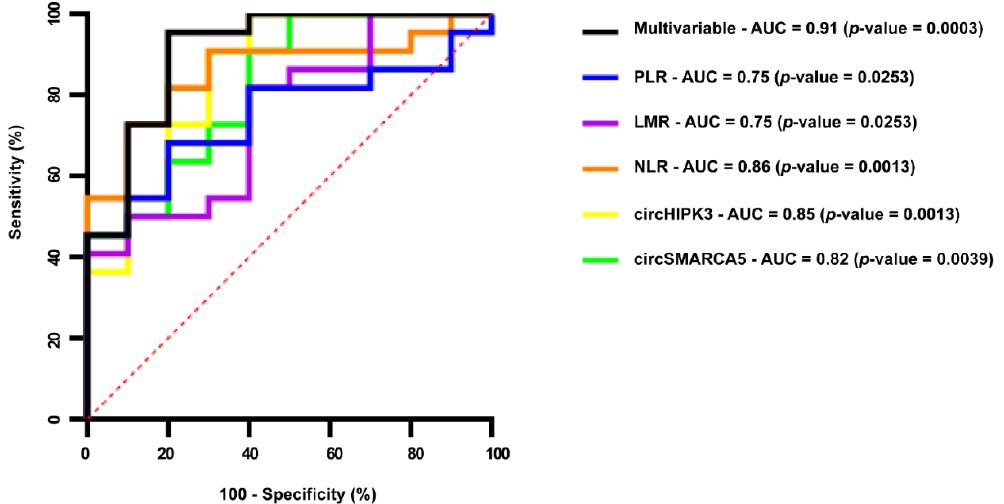
Figure 4. Univariable and multivariable receiver operating characteristic (ROC) curve analysis based on the expression of sEV-derived circSMARCA5 and circHIPK3, NLR, PLR, LMR and their combination.